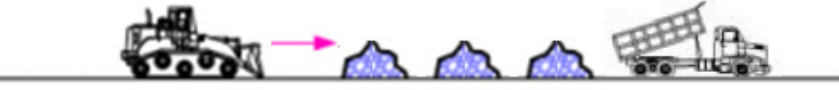
Figure 12. Filtered Tailings Spreading Operation–Construction Method.